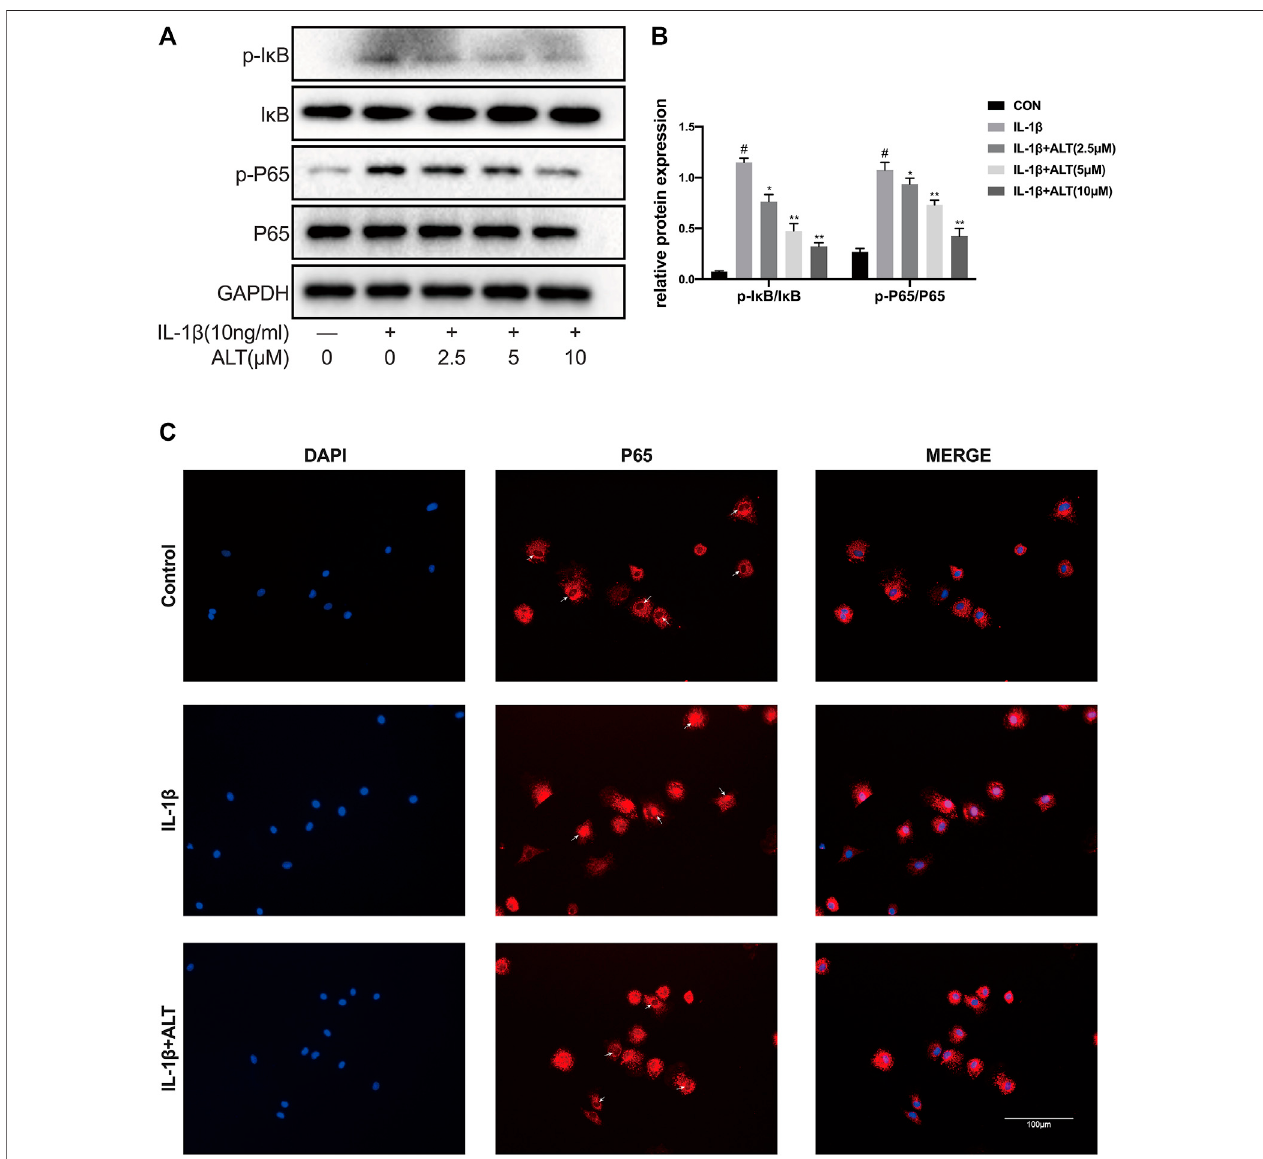
FIGURE 8 | ALT relieved IL-1 β -induced NF- κ B signaling pathway activation in mouse chondrocytes. Cells were exposed to ALT (10 μ M) with or without IL-1 β (10 ng/ml) for 30 min. (A) Protein levels of p- I κ B, I κ B, p-p65, p65 were detected by Western blot. (B) Relative protein expression was quali fi ed by ImageJ software, I κ B and p65 were used as the loading control, respectively ( n (cid:2) 3). (C) p65 translocation was observed by Immuno fl uorescence (scale bar 100 μ m). # p < 0.05 vs. control group; * p < 0.05 vs. IL-1 β group; ** p < 0.01 vs. IL-1 β group.